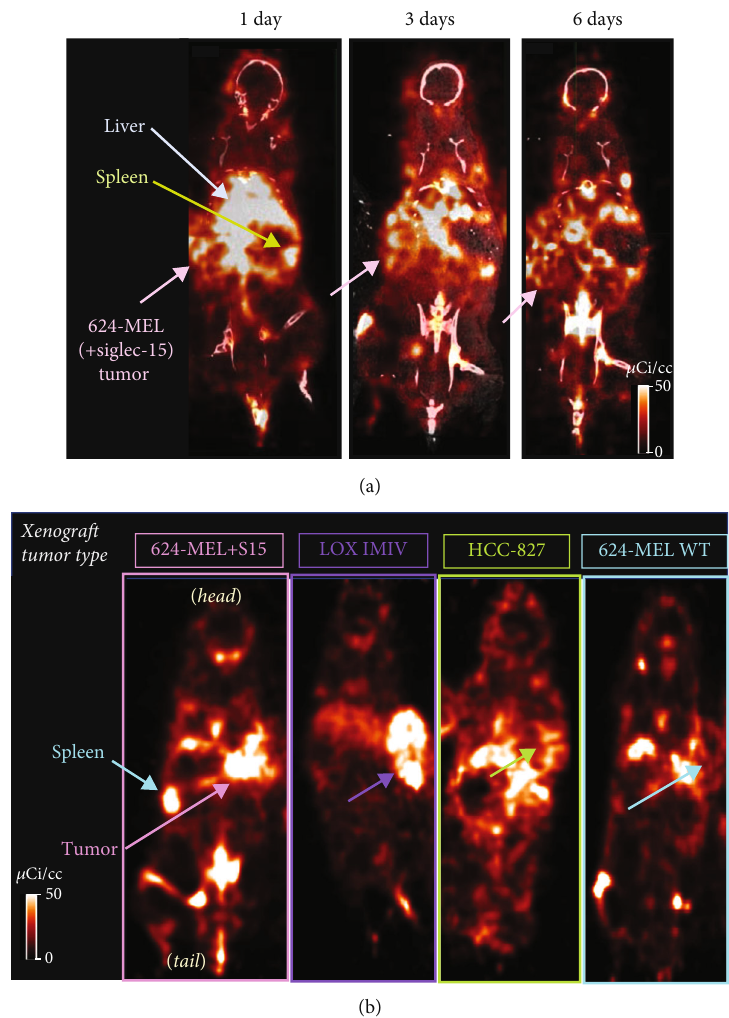
Figure 6: (a) Coronal PET/CT images of 624-MEL+S15 mouse xenografts at 1, 3, and 6 d post injection of [ 89 Zr]Zr-DFO-NC318 (3.7 MBq (100 μ Ci), associated mass ~ 20 μ g). (b) PET images of 624-MEL+S15, LOX IMIV, HCC-827, and 624-MEL WT mouse xenografts at 3 d post injection of [ 89 Zr]Zr-DFO-NC318 (3.7MBq (100 μ Ci), associated mass ~ 20 μ